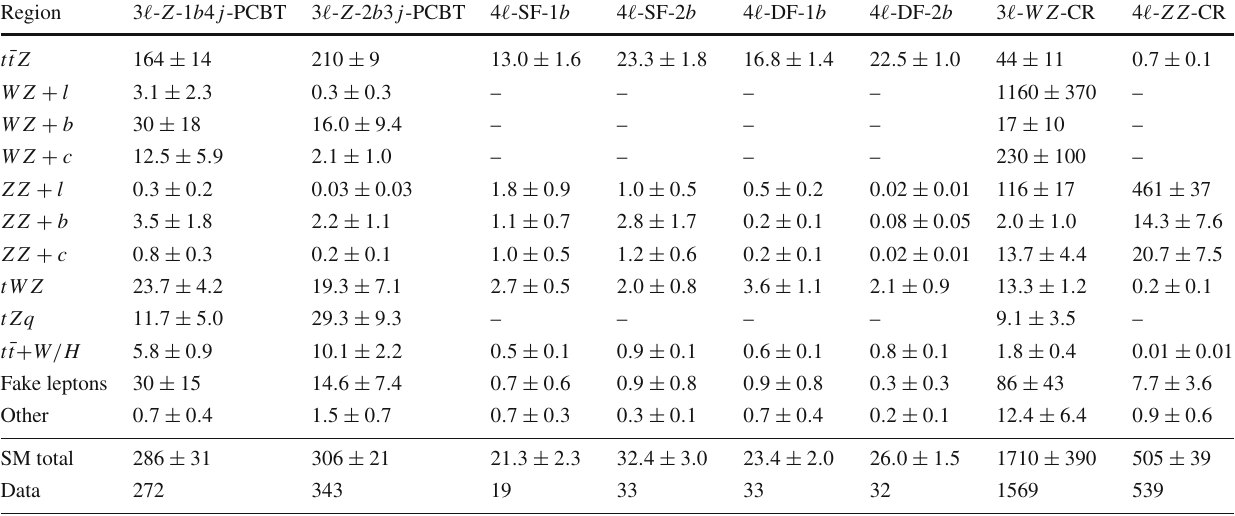
Table 4 The observed and expected numbers of events in the trilepton and tetralepton signal regions, as well as in the W Z / Z Z + jets control regions. The predictions are shown before the fit to data. The W Z and Z Z + jets backgrounds are listed separately for their light-flavour ( l ), b -jet and c -jet components. The category ‘fake leptons’ refers to the contributions from fake and non-prompt leptons. ‘Other’ includes the